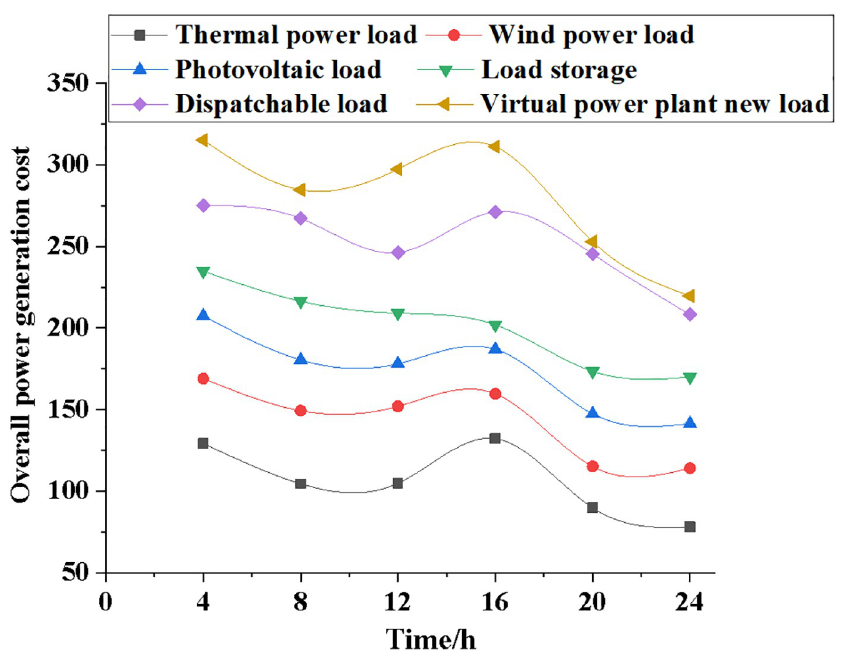
Fig 12. Comparison and analysis of total power generation costs for different power load